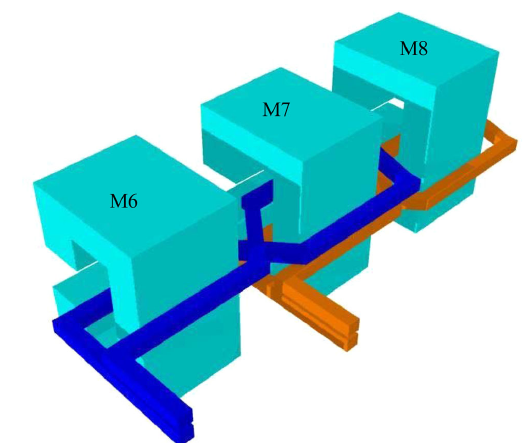
FIG. 44. Two sets of figure-eight back-leg coils for COD